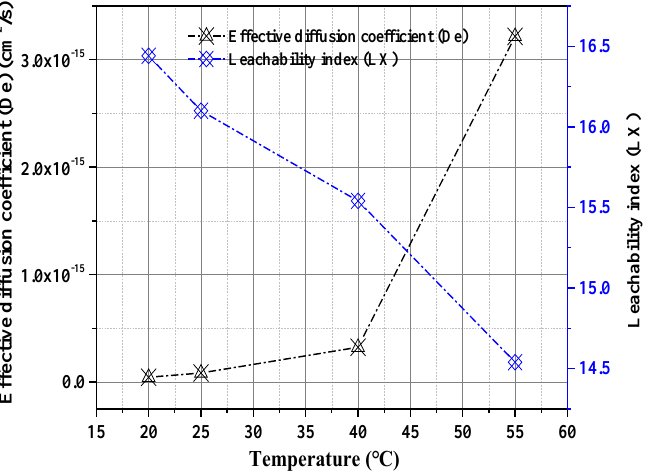
Figure 3. Leachability index and effective diffusion coefficients for the leaching tests conducted at different temperatures.